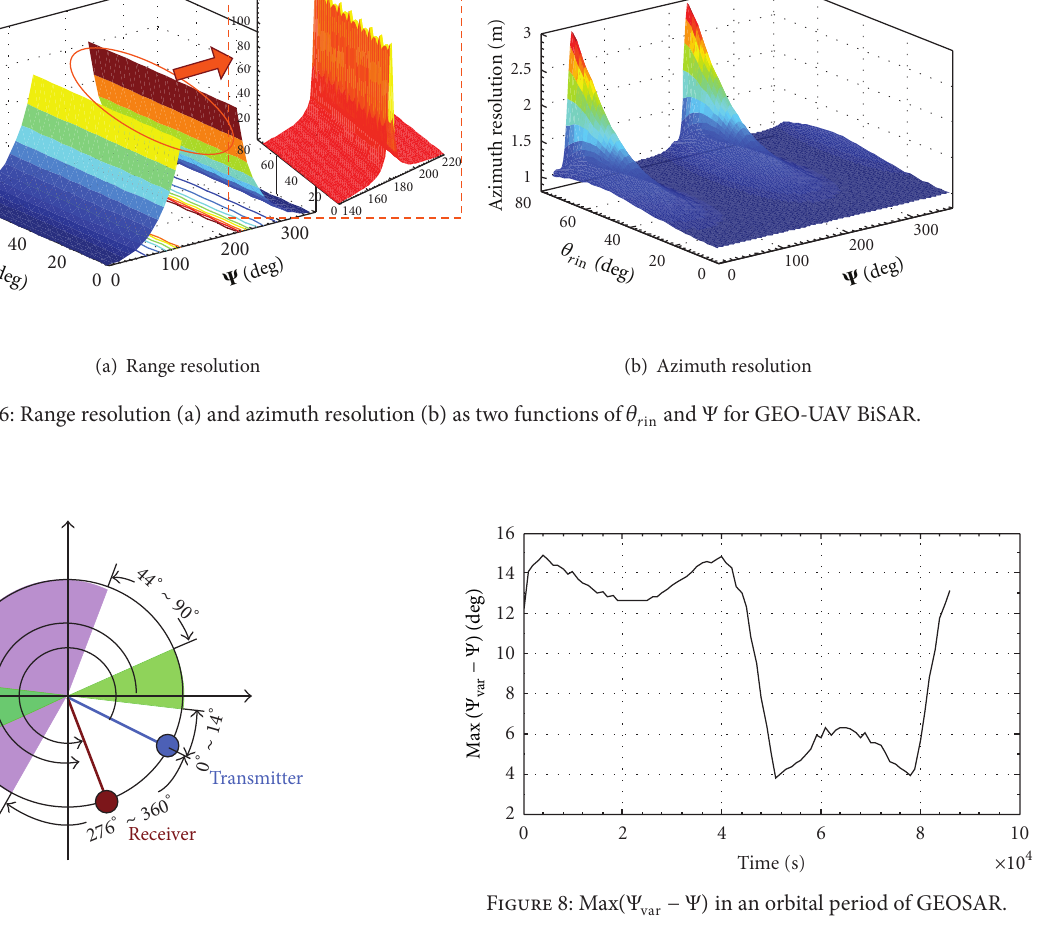
3, whereas we need to avoid Ψ that appears in area 1 and area > 45 ∘ . 3 if 𝜃 𝑟 in With the mutual movement of two platforms ( 󳨀⇀ 󳨀⇀ 𝑡 ) ̸= 𝑉 𝑉 (𝑡 +𝑡 ) is time varying), the variational range 𝑎 𝑅 , and 𝑒𝑇 0 𝑎 is different in the periodical time of GEOSAR. of Ψ var